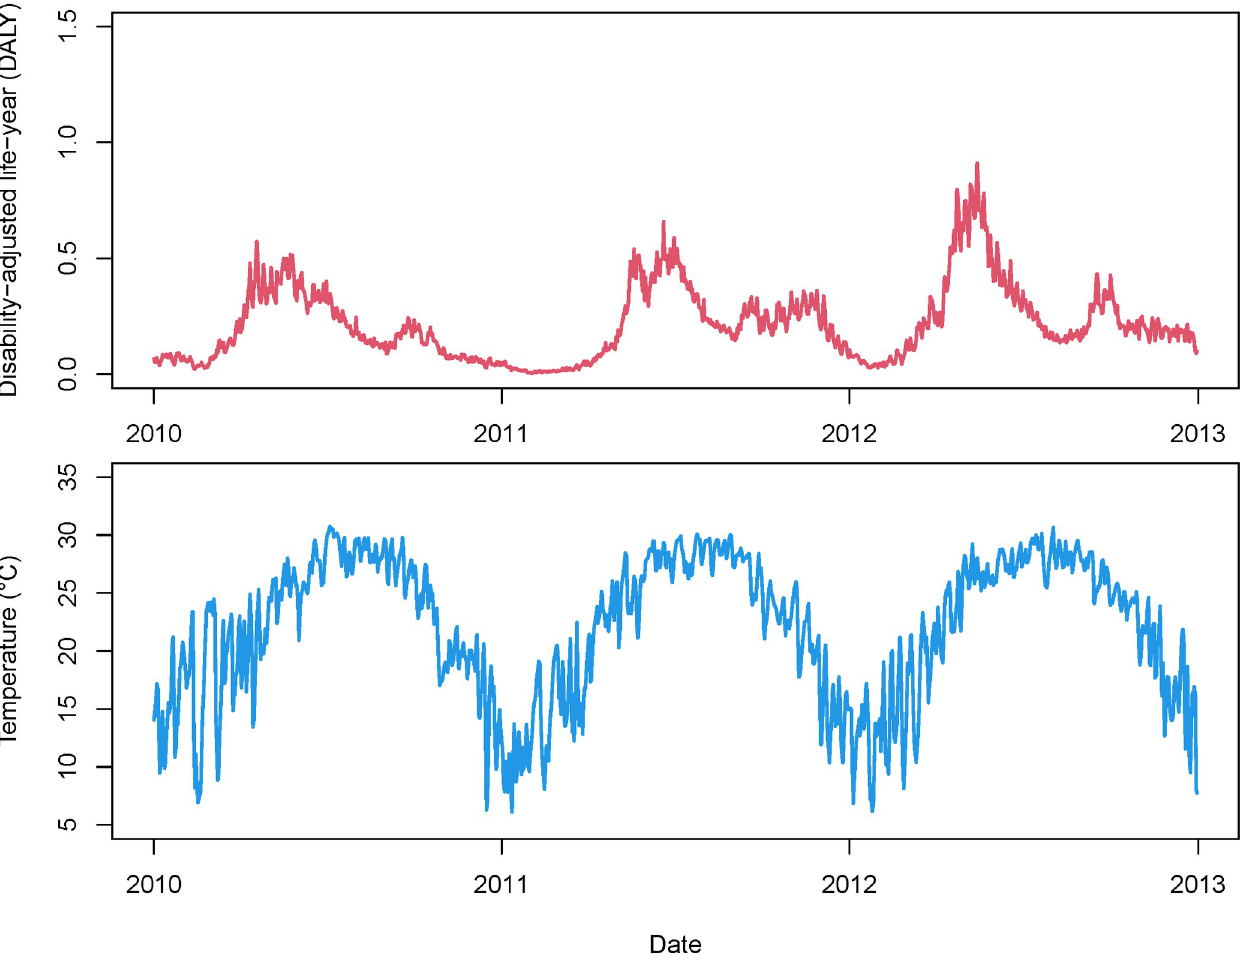
Fig 1. Daily time-series of DALY and average temperature of HFMD in Guangdong, 2010–2012. Daily DALY is the sum of the DALY of each day; Daily temperature is the average of the temperature of each